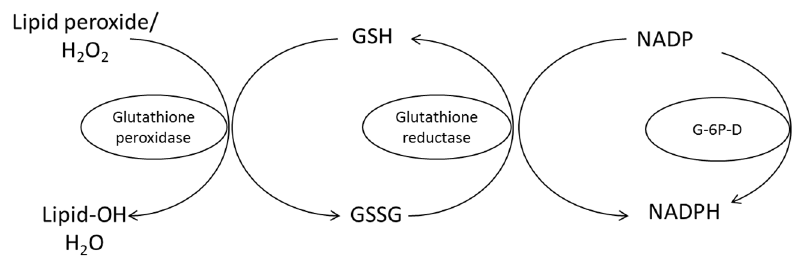
Figure 8. Conversion oxidized glutathione (GSSG) to the reduced form (GSH) by glutathione reductase requires RF in the FAD co-enzyme form for its activity. G-6P-D, glucose-6-phosphate dehydrogenase [98].